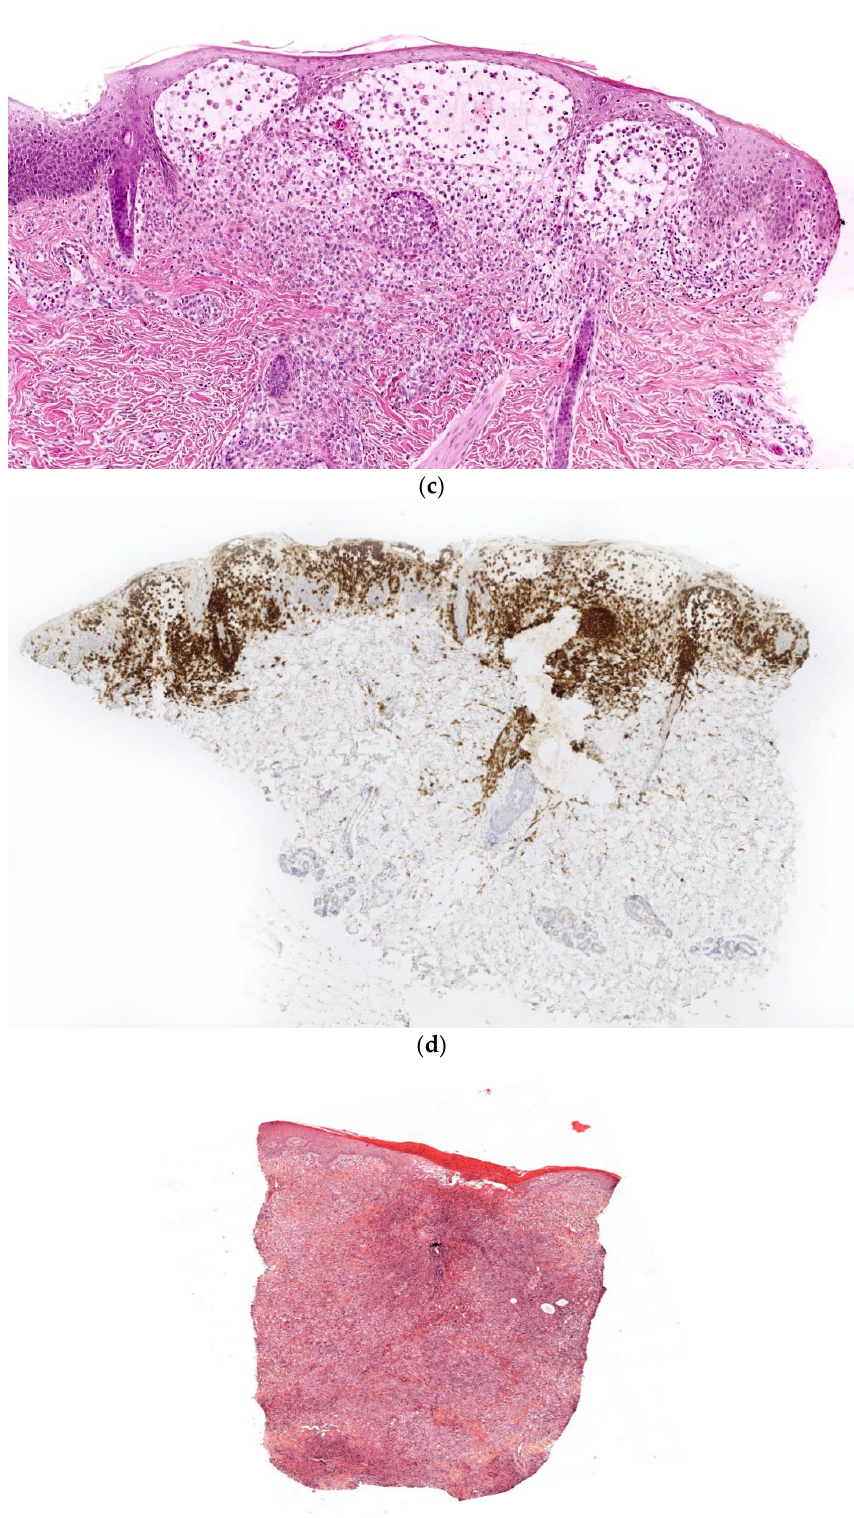
Figure 7. Langerhans cell histiocytosis ( a ) disseminated congenital lesions with erosive and purpuric lesions. ( b ) nodular and crusted lesion (Hashimoto-Pritzker). ( c ) 2.5 × usual aspect of LCH with Langerhans cell infiltrate filling the papillary dermis. ( d ) 2.5 × anti-CD1a. ( e ) 2.5 × Nodular spontaneously regressive lesion. Dense infiltrate throughout the dermis with very few